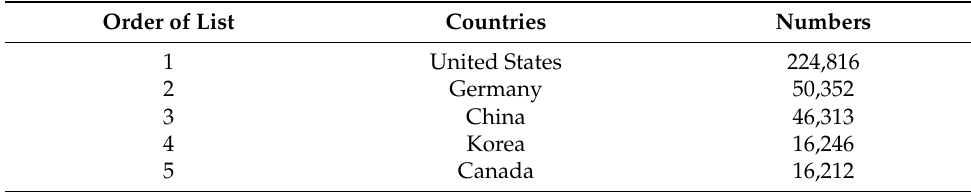
Table 6. The top 5 countries of ICS